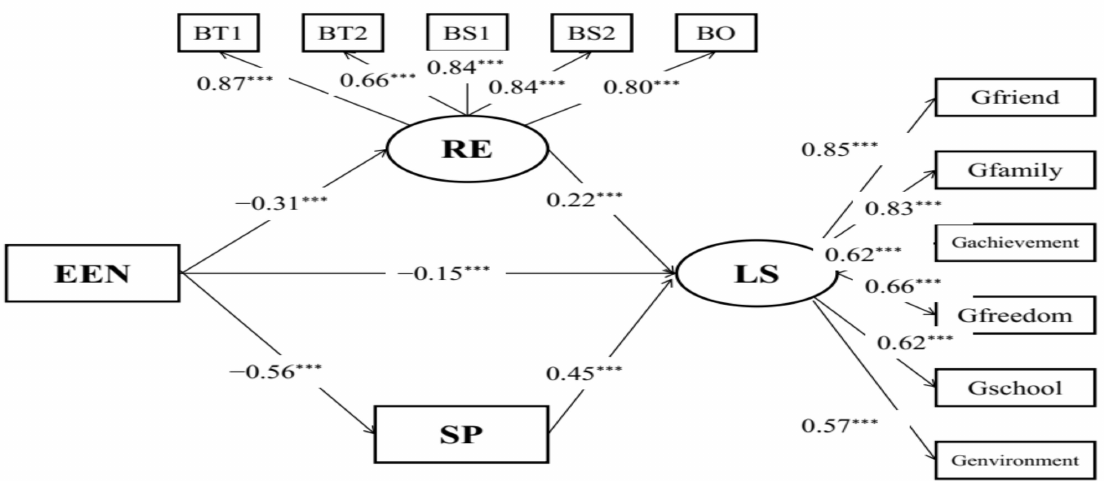
Figure 7. Mediation model of emotional neglect, life satisfaction, resilience, and social support. EEN: emotional neglect; BT1: tenacity 1; BT2: tenacity 2; BS1: strength 1; BS2: strength 2; BO: optimism; LS: life satisfaction; RE: resilience; SP: social support; *** p <